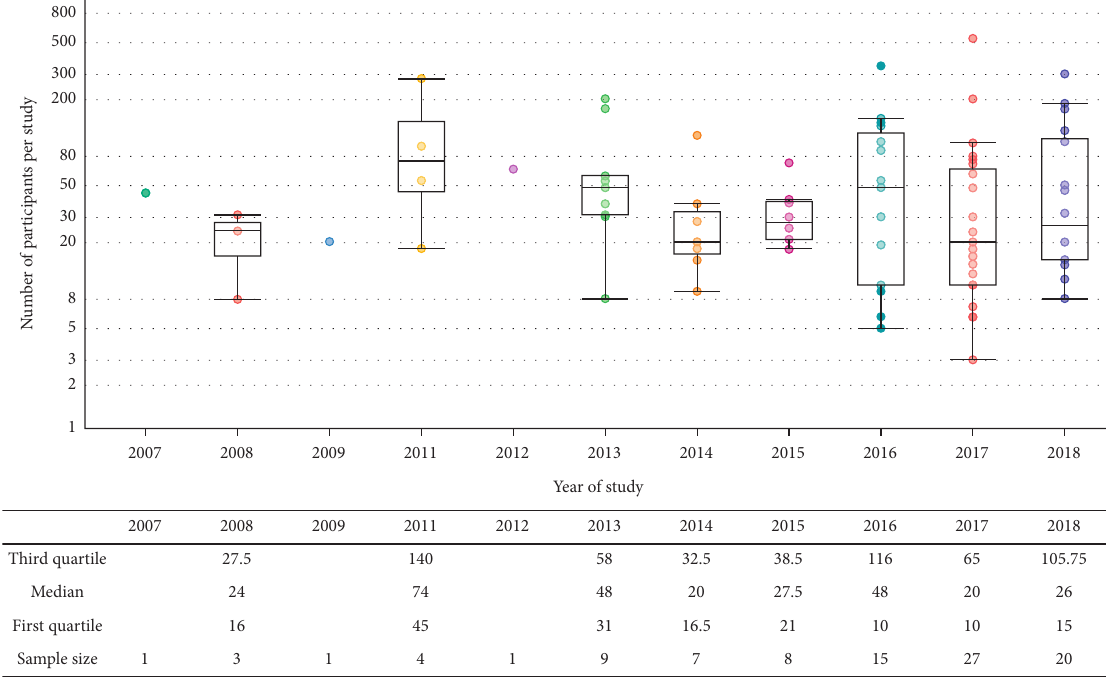
Figure 8: Number of participants per study in journal studies by